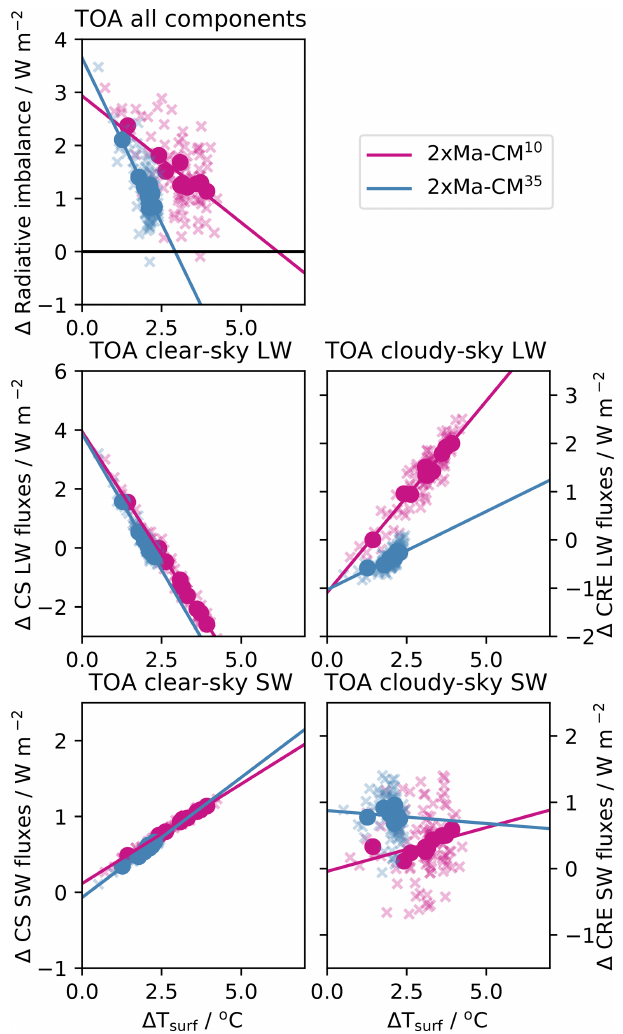
Figure 11. Gregory analysis of HadCM3-BL: regression of top- of-atmosphere radiative imbalance against surface air temperature change (solid lines) for the first 100 years of 2 × Ma-CM 10 (pink) and 2 × Ma-CM 35 (blue) cases. Annual averages are indicated by crosses and decadal averages are indicated by filled circles. The re- gression was performed on the decadal averages.